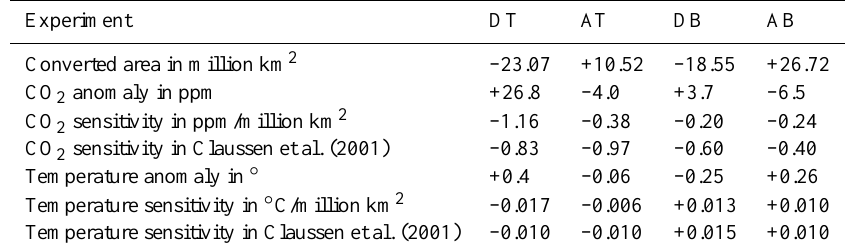
Table 6. Sensitivities of temperature and CO 2 in comparison with Claussen et al. (2001), averaged over the final 150years. In the case of tropical deforestation, the CO 2 anomaly was averaged over the final